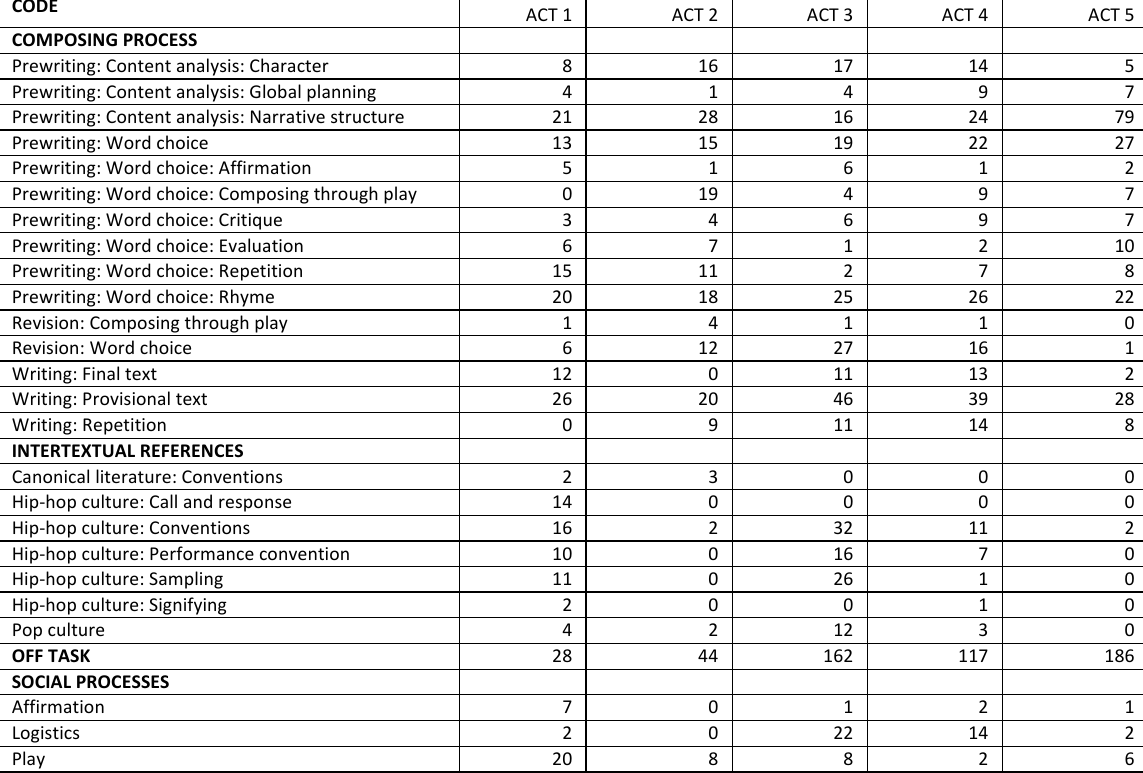
Table 1: Codes and